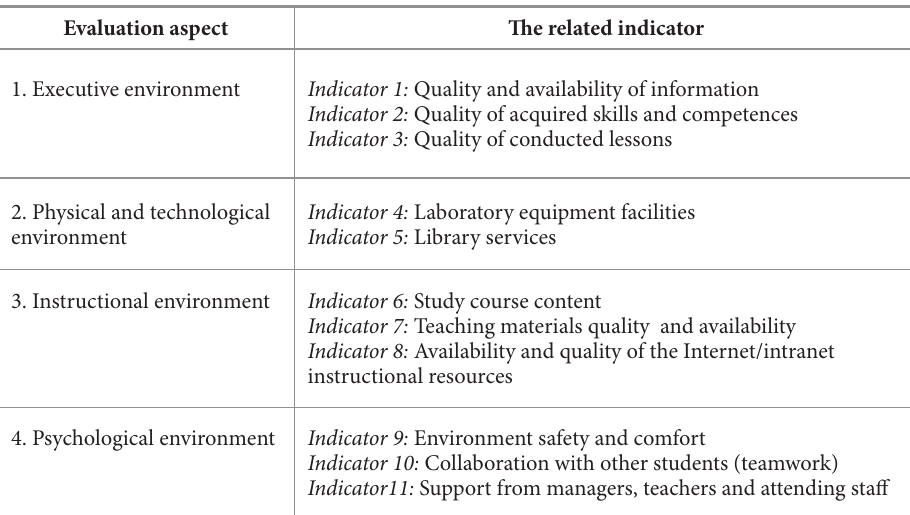
Table 3. The basic educational environment aspects and the proposed indicators for performing their